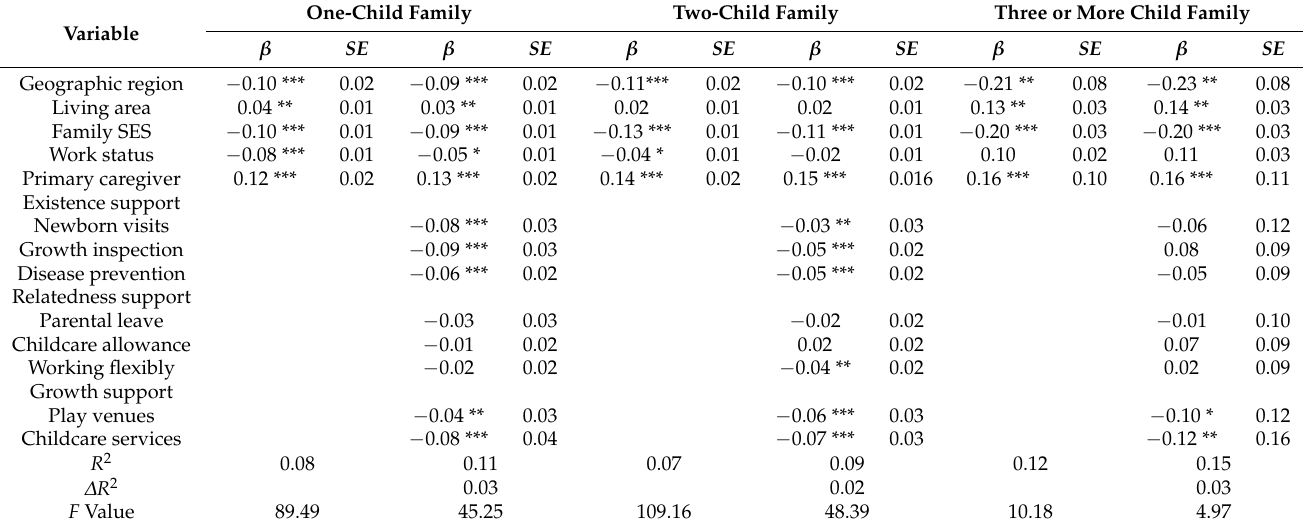
Table 4. Regression results for family support for infant and toddler care predicting parenting